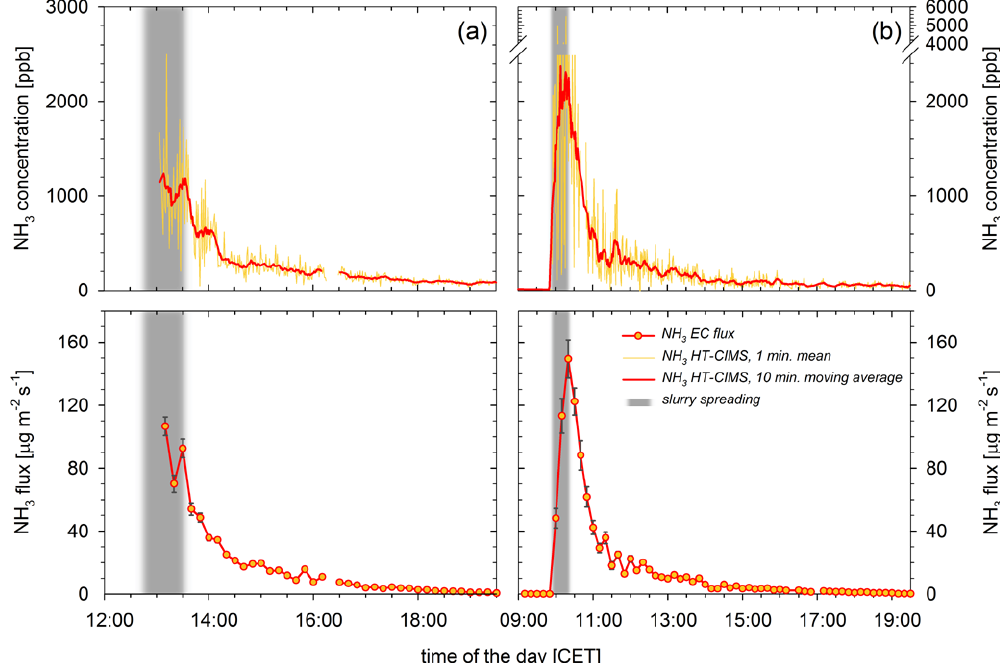
Fig. 10. NH 3 concentrations and EC fluxes measured at 1ma.g.l. during and after the spreading of slurry on (a) 4 August 2009 (crop stubble field) and (b) 6 August 2009 (cut grassland); vertical error bars of NH 3 fluxes represent the precision of the flux, shaded areas indicate the period of slurry spreading affecting the fetch of the measurement.